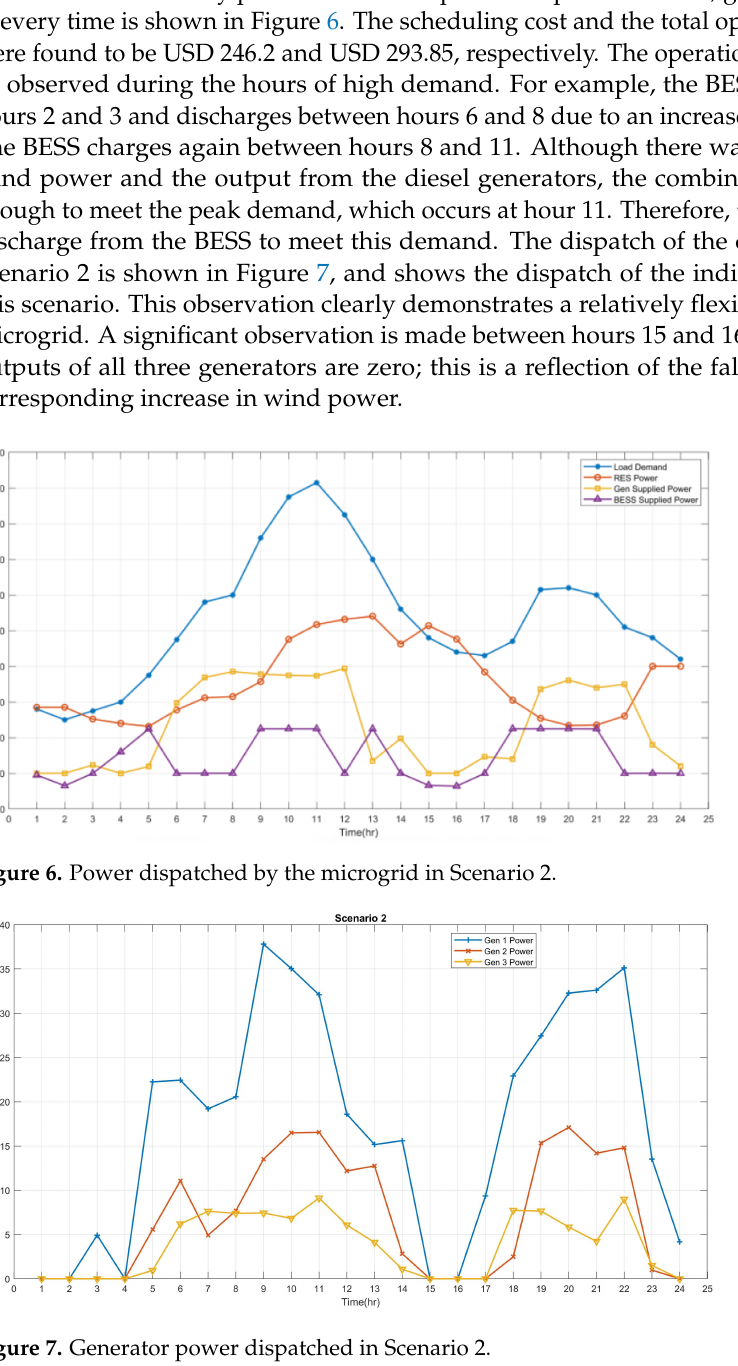
Figure 7. Generator power dispatched in Scenario